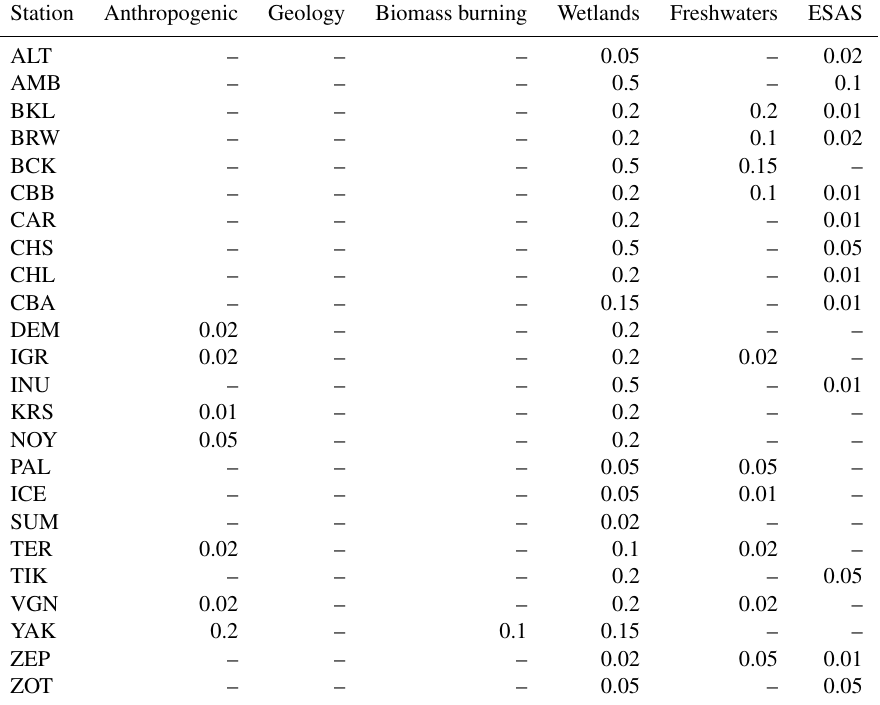
Table 4. Minimum detectability threshold (in ‰) of high northern-latitude sources at all observation sites in 2012 considering the mean values of isotopic signature in Table 2. See Sect. 3.3 for the definition of the detectability